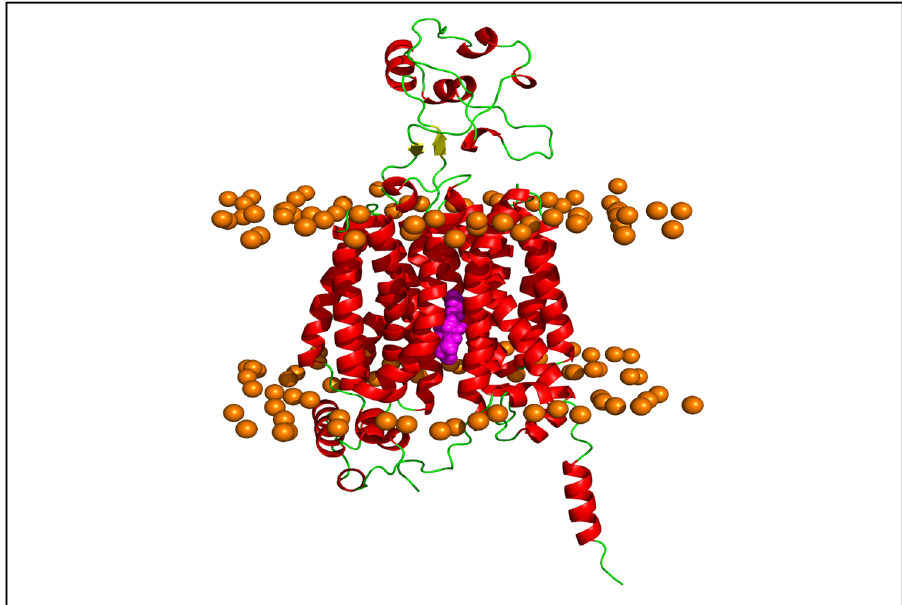
Figure 2. 3D structure of SLC22A2 protein embedded in the POPC lipid bilayer membrane: the SLC22A2 protein structure (coloured by secondary structure) in complex with the 5RE inhibitor (shown as spheres in magenta) phosphate lipid head groups shown as orange spheres.